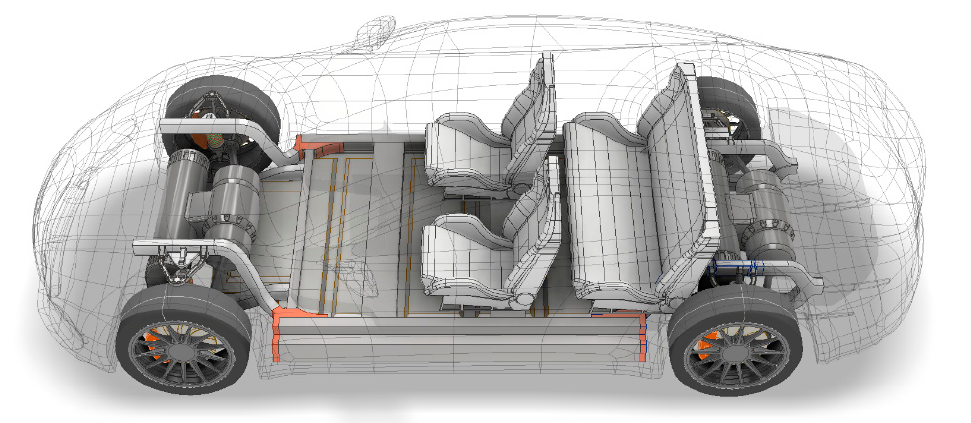
Figure 4. Powertrain architecture.